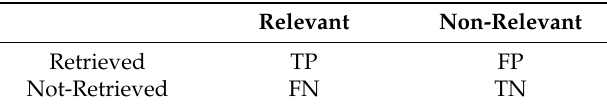
Table 3. Computed values of Precision and Recall.